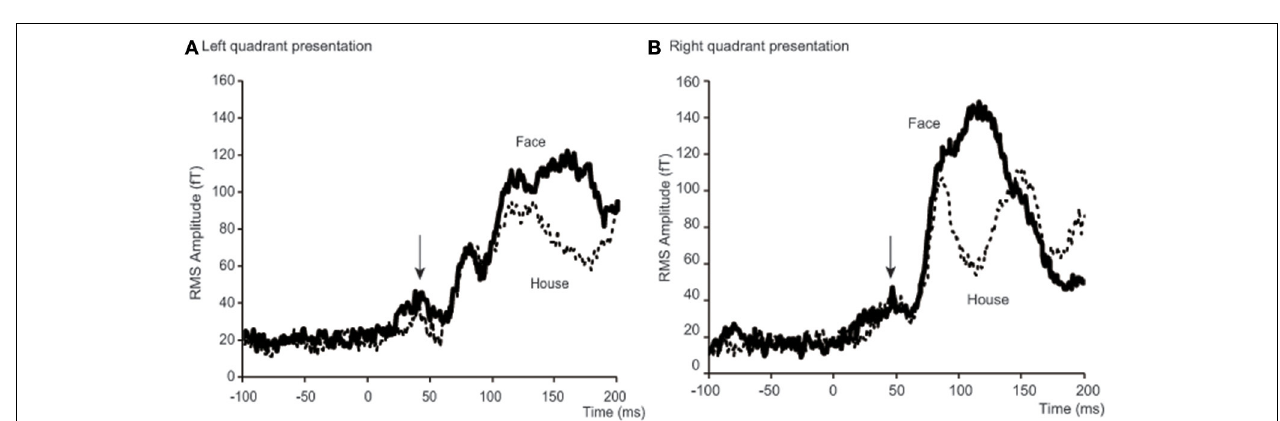
difference is only clear after 100ms. Arrows indicate a peak at around 40ms after stimulus onset. Although N170 responses are shown between 100 and 200ms for left quadrant presentation (A) and 80 and 150ms for right presentation (B) , we do not discuss these components in this paper, because our interest was with the early responses